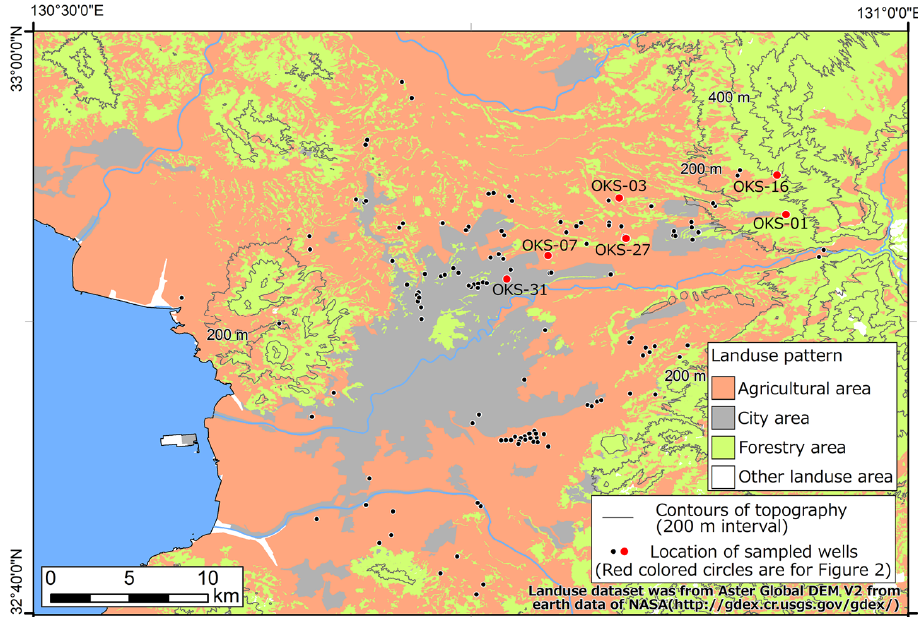
Figure 3. Land-use map with sampling wells in the Kumamoto area.